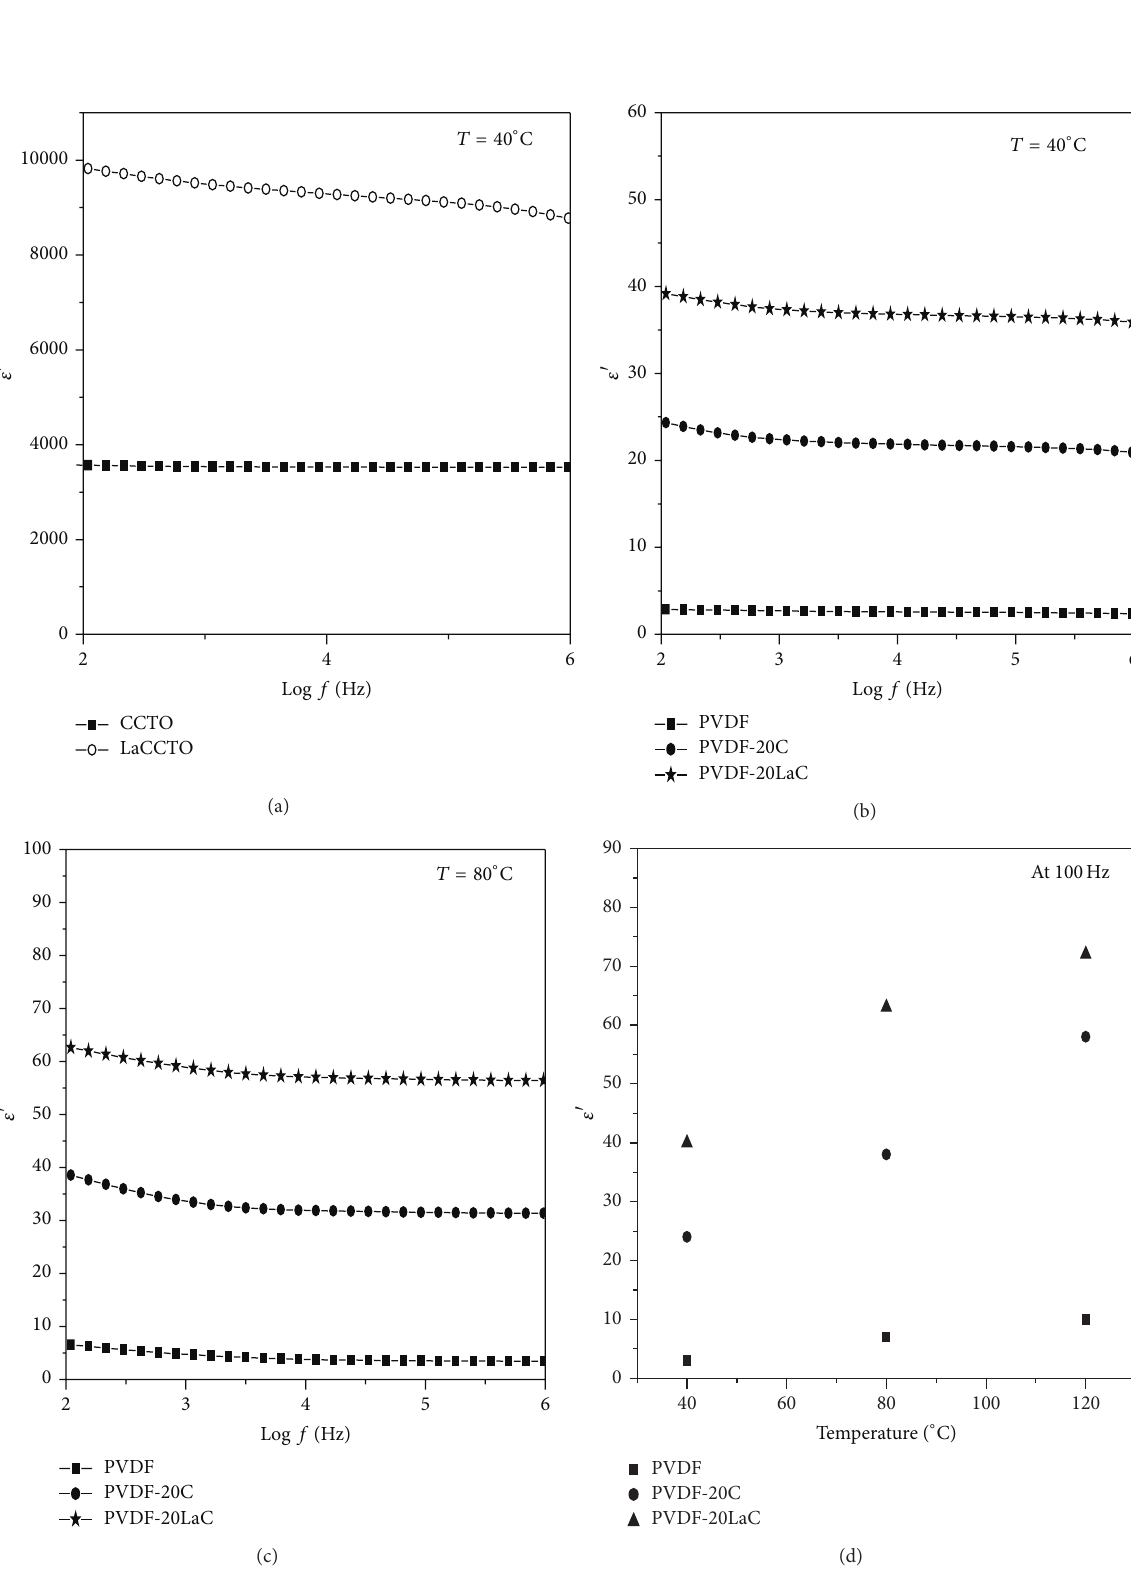
Figure4: Frequency dependence ofeffective dielectricconstant ofCCTOand LaCCTO(a),PVDF, PVDF-20C, andPVDF-20LaC composites at 40 ∘ C (b), at 80 ∘ C (c), and at different temperature